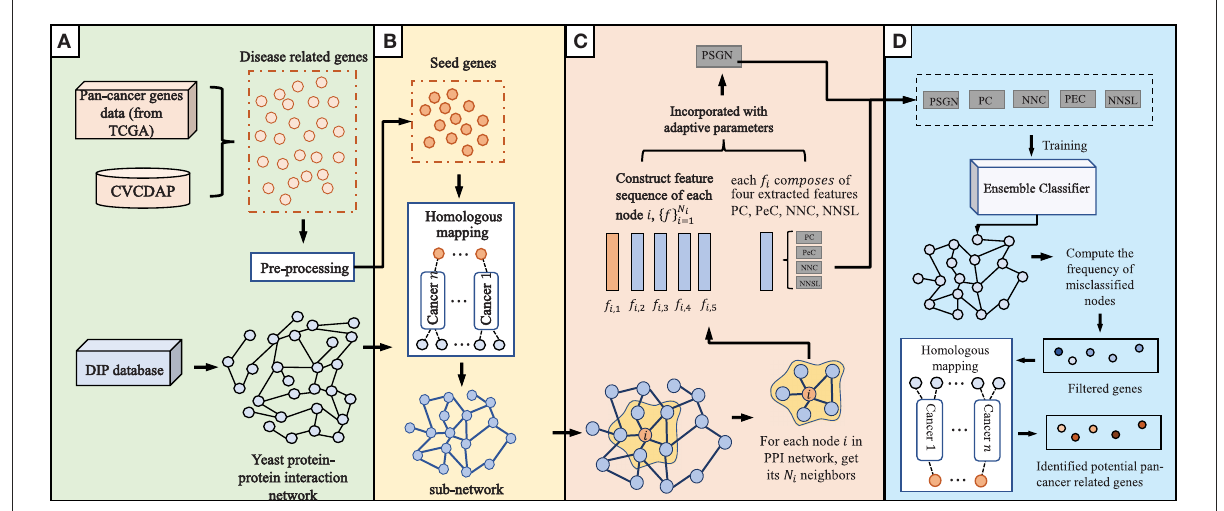
FIGURE1 An overview of our proposed method to predict pan-cancer related genes via orthologs matching. The main algorithm consists of (A–D) four parts. (A) data integration and pre-processing. (B) Homologous mapping. (C) Evaluation of node representation ability in graph. (D) Prediction of pan-cancer related